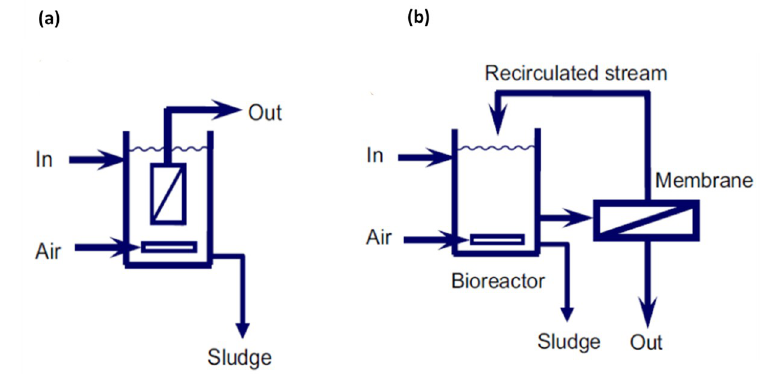
Figure 2. Configurations of a membrane bioreactor: ( a ) immersed and ( b ) sidestream [59]. Reproduced with permission from [59], Copyright Journal of Membrane Science, 2011.